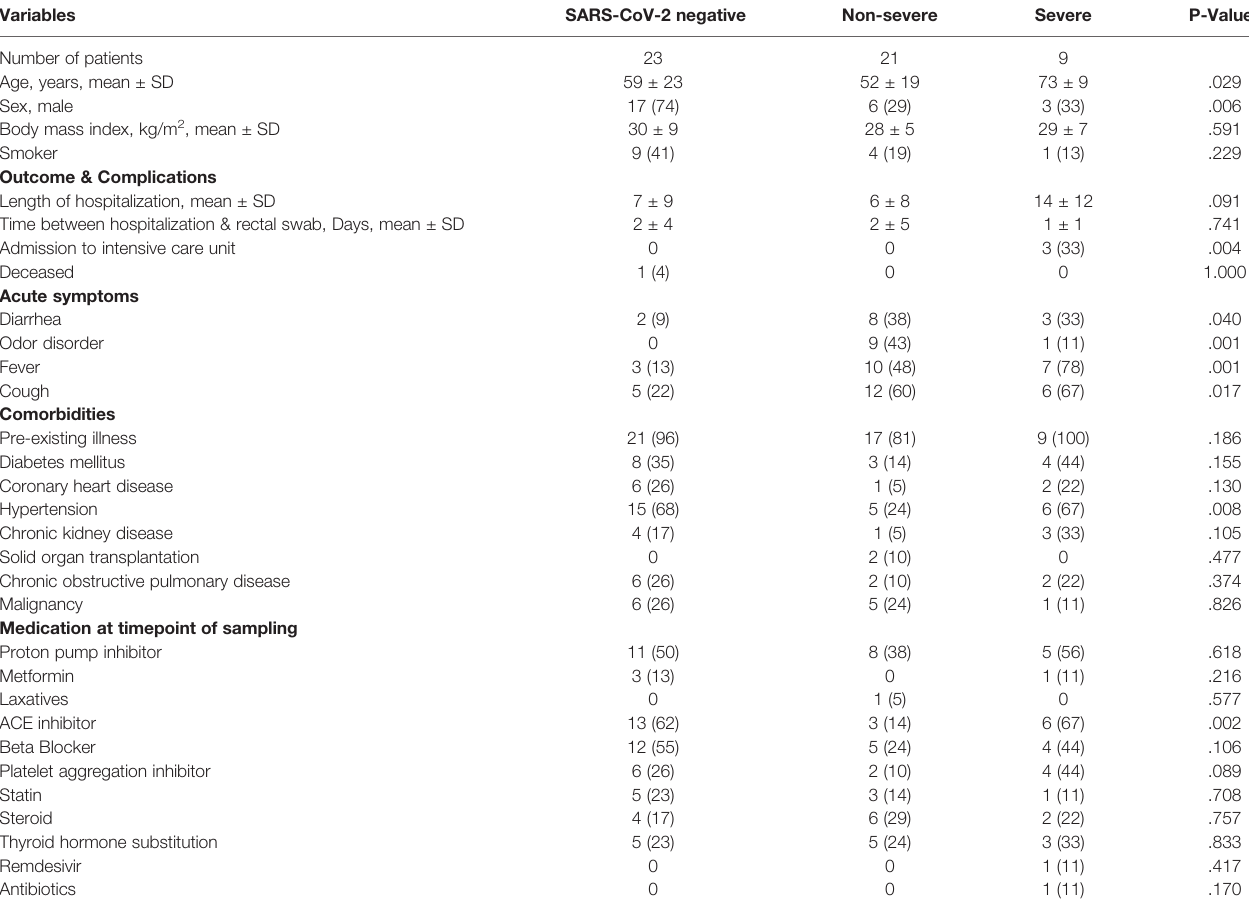
TABLE 1 | Characteristics of SARS-CoV-2 negative and positive patients linked to COVID-19 disease